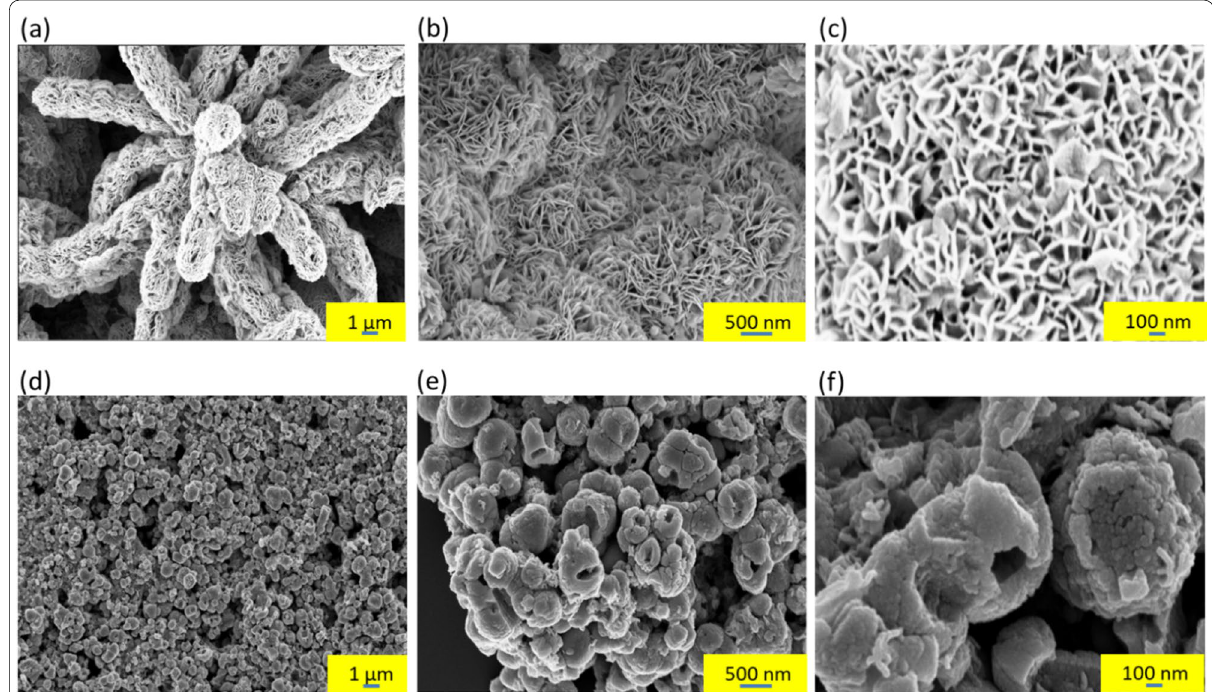
Fig. 2 FE-SEM images of a – c the WS 2 NFs and d – f WS 2 –WC–WO 3 NH spheres at different